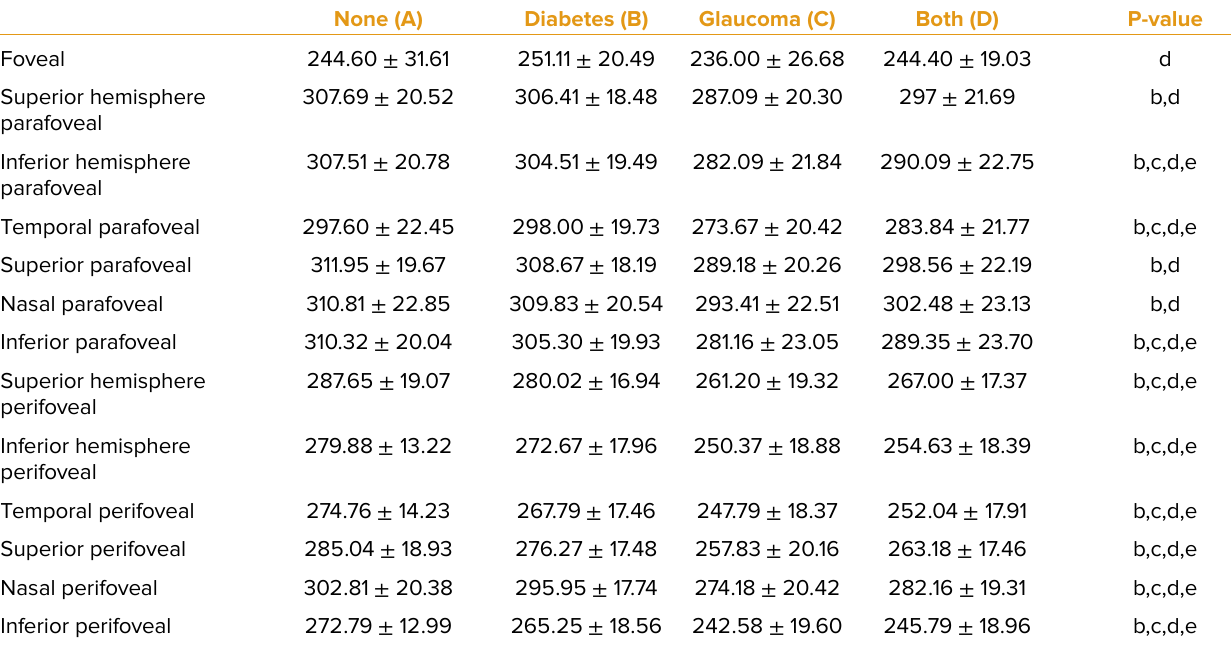
Table 3. Table showing the foveal parameters in patients with diabetes, glaucoma, both (diabetes and glaucoma), and none (43 eyes each).